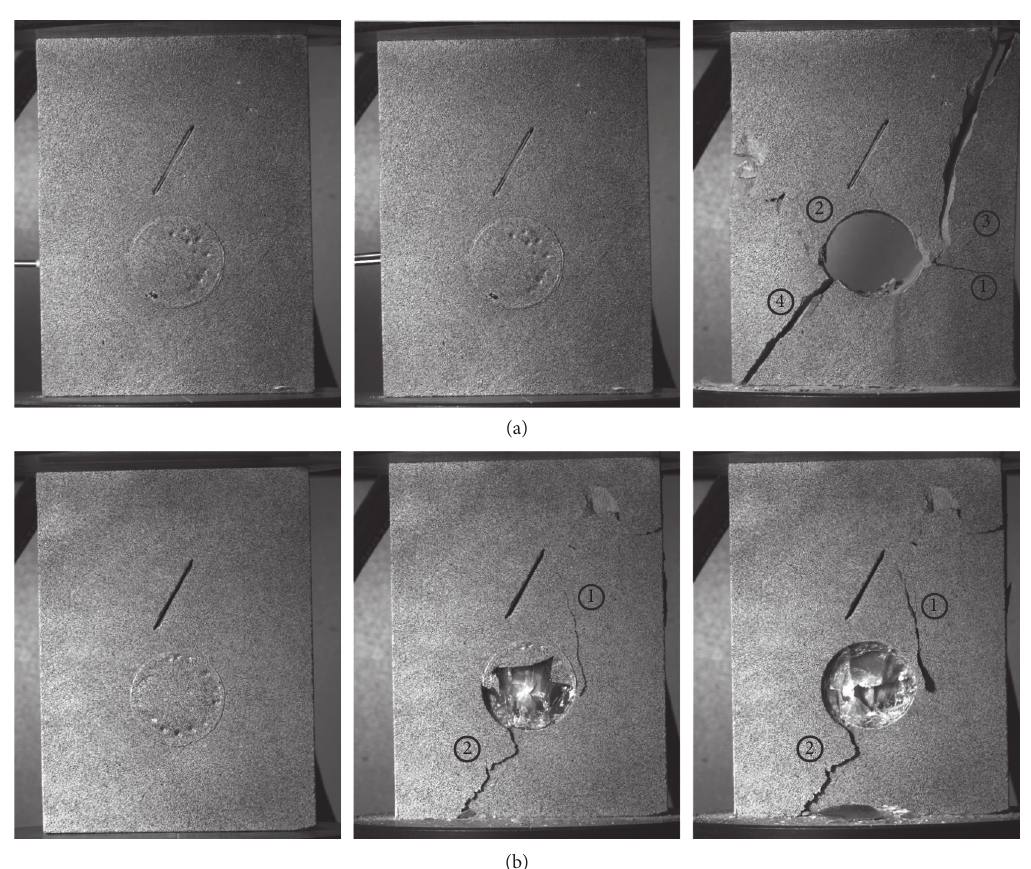
Figure 7: Crack evolution process of α � 60 ° : (a) S-60-80; (b)